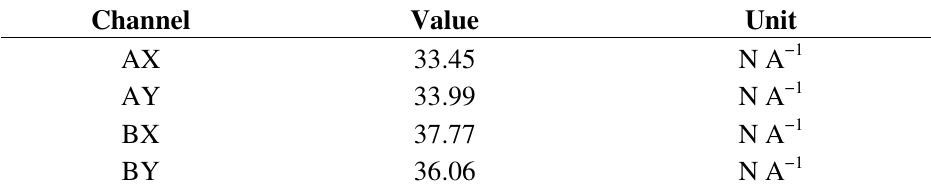
Table 2. The measured results of the current